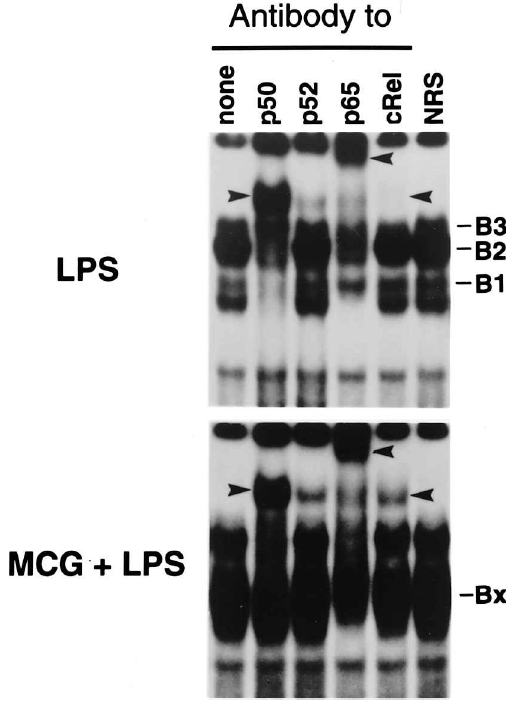
FIG. 2. Supershift analysis of NF- k Bx proteins generated following phagocytosis of MCG. J774 cells were incubated for 3h at 37°C without MCG (top) or with MCG (bottom) at a macrophage to mast cell ratio of 5 to 1. They were then exposed to LPS (10ng/ml) for 30min at 37°C. The nuclear proteins extracted from the cells at the end of incubation period were incubated at 25°C for 30min with antibodies against the N-terminals of p50, p52, p65 or c-Rel or with control non-immune rabbit serum, and then subjected to EMSA as in Fig. 1. Autoradiographs were prepared by exposing to X-ray films for 14.5h. Arrows indicate the supershifted bands. Similar experiments carried out using antibodies against the C-terminal peptides of p65 or c-Rel did not show any supershifted band (Data not